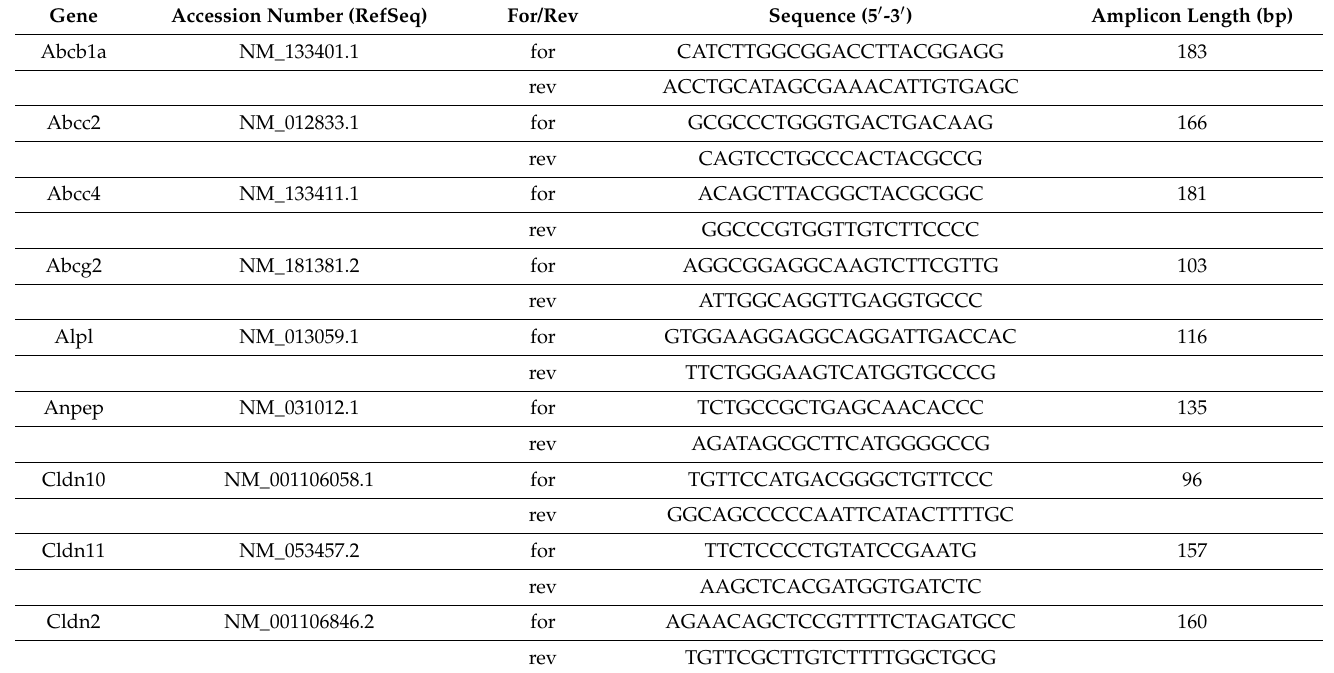
Table 3. List of primers used for qPCR (Rattus